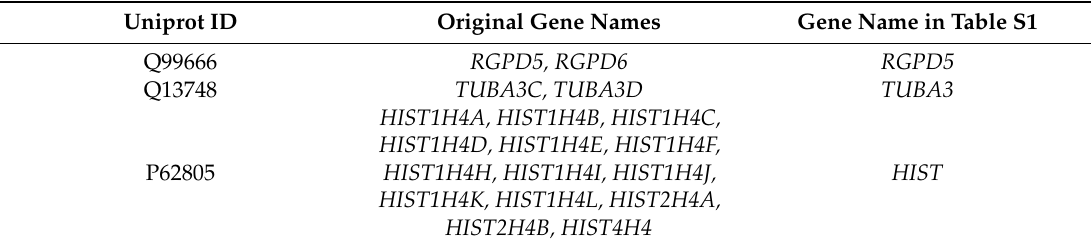
Table A1. Clarification note for Table S1 1